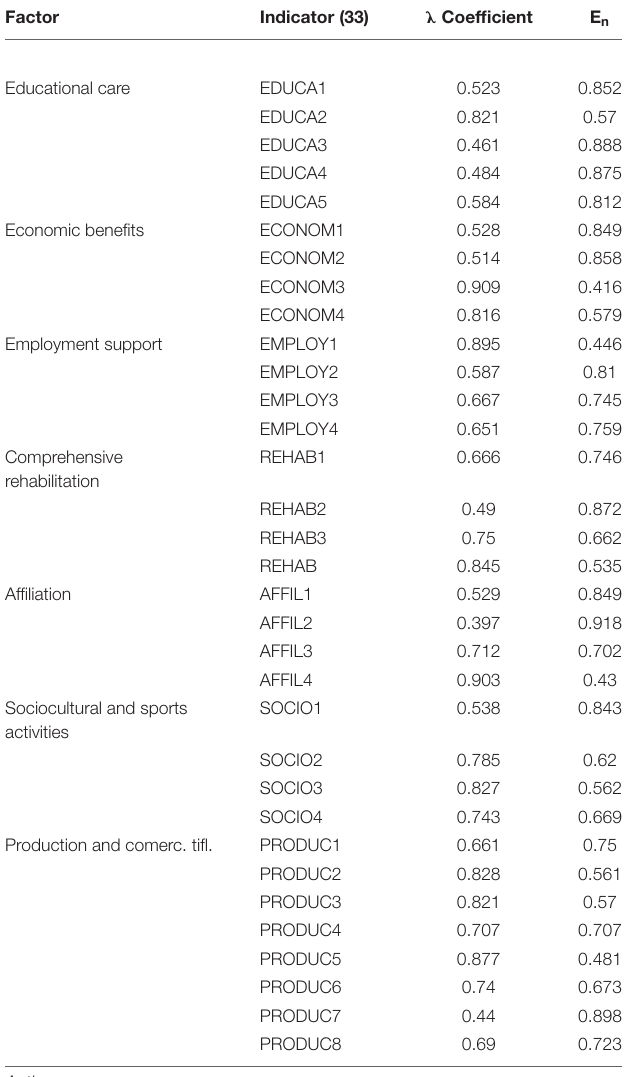
TABLE 6 | Reliability of the Cronbach’s α scale. TABLE 7 | Standardized solutions of FCA of social management NPO’s scale.